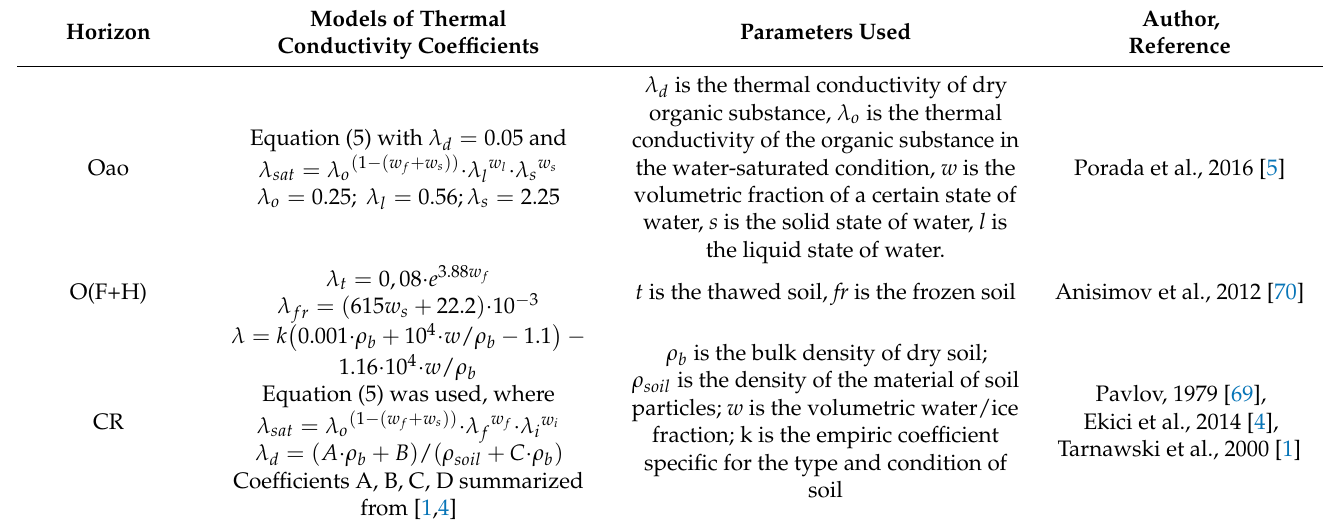
Table 3. Models of thermal conductivity coefficients used for different soil horizons. Models of Horizon